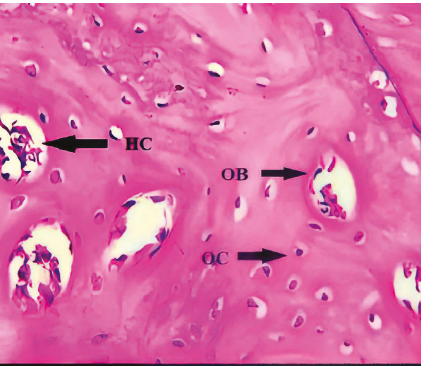
Figure 6: A view of the defect site in the GS/PSO group shows the Haversian canals lined by OB and surrounded by OC after 4-weeks. H&E x40.